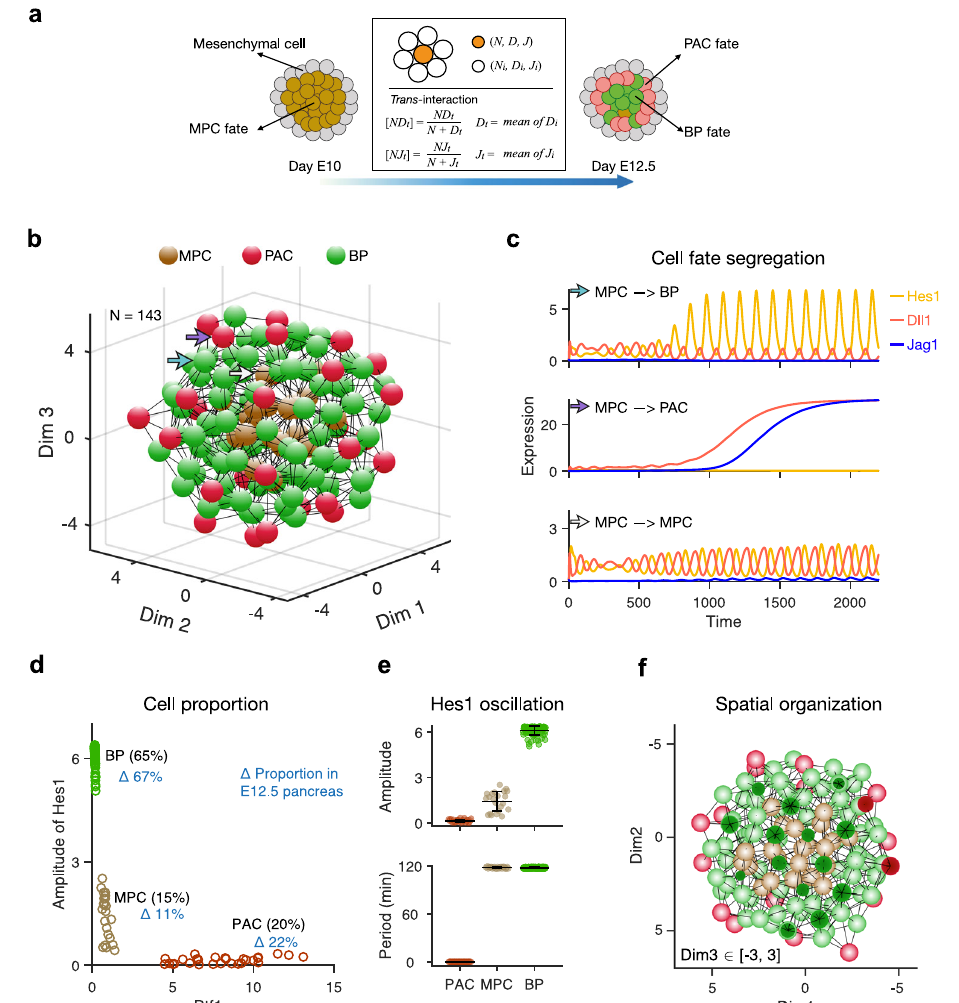
Fig.3|MathematicalmodelforNotchsignalingmediatedMPCdifferentiation. a SchematicdiagramofhowthesimulatedcellsdifferentiatefromMPCfatetoPAC fateorBPfateina3DstructureduringE10~E12.5.Differentcolorsindicatedifferent cell fates hereafter: brown, MPC; red, PAC; green, BP. Cells receive ligands from theirneighborsandchangetheirgeneexpression. b E12.5pancreasinsilico.Spatial organizationofdifferentcellfatesinthesimulatedpancreaticepitheliumatE12.5is shown with nodes (cells) and edges (interactions). Colors of nodes indicate three different fates: Brown: MPC fate, red: PAC fate, and green: BP fate. c Examples of gene expression dynamics when cells differentiate to BP fate (top) and PAC fate (middle) or maintain MPC fate (bottom). Hes1 (yellow), Dll1 (red), and Jag1 (blue) change along the developmental time (min). Hes1 and Dll1 show comparable anti- phaseoscillationinthesamecellwhenthecellisatMPCstate.Thepositionsofthe